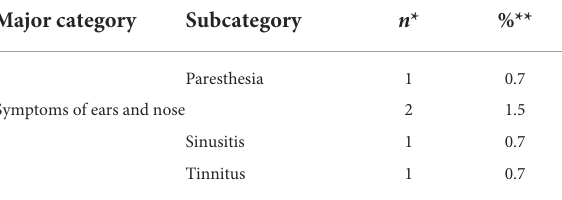
TABLE 3 Additional reported symptoms of patients with long COVID lasting between 4 and 12 weeks.